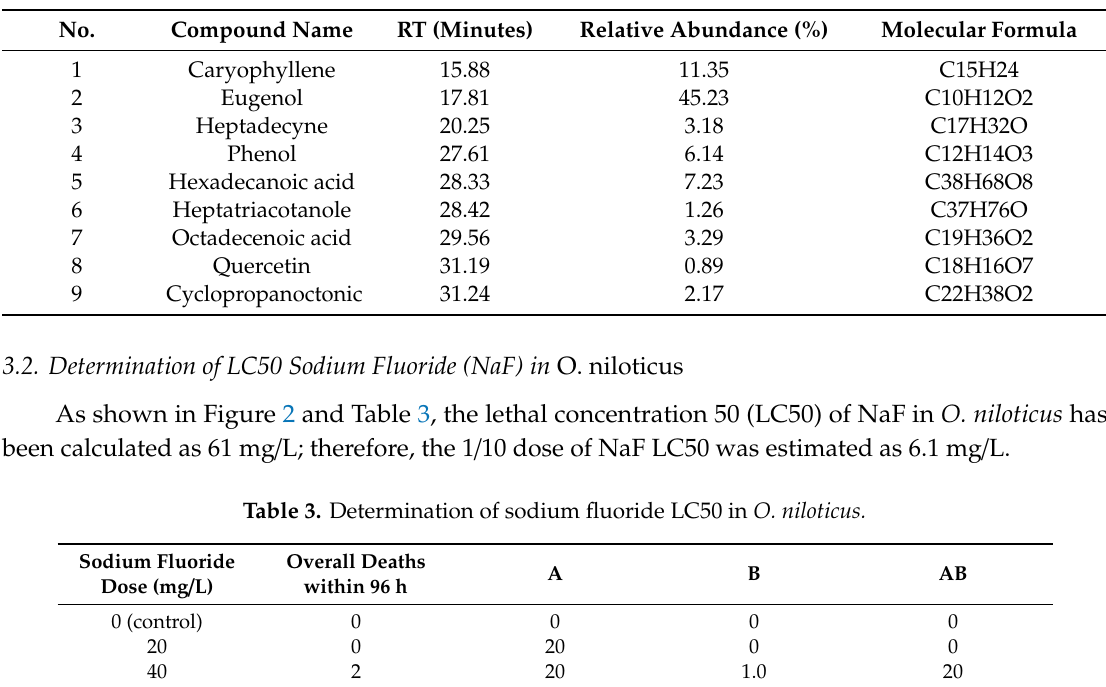
Table 2. GC-MS analysis of major phytoconstituents present in Moringa oleifera leaves ethanolic extract.